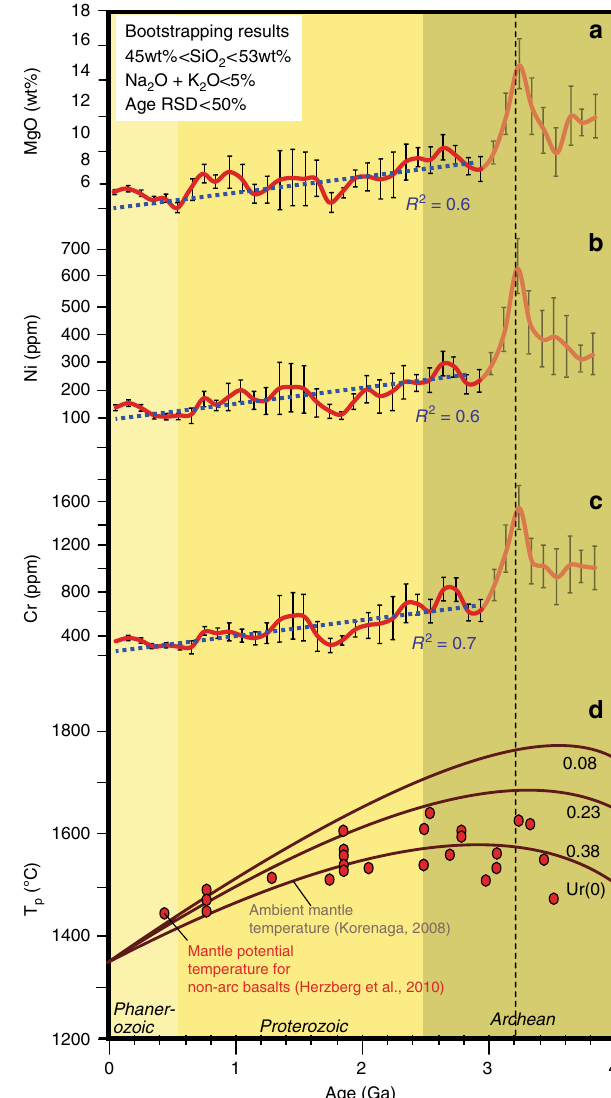
Fig. 3 Time evolution of global mean MgO, Ni, and Cr contents after a bootstrap resampling of the selected basaltic database. The blue dashed lines in a – c are regression lines for data between 0 to 3.0 Ga that reveal fi rst-order secular decreases. Error bars in a – c show 2 s.e.m. (standard error of the mean) uncertainties. d Secular cooling of Earth ’ s mantle based on non-arc basalts 28 and thermal modeling 43 . Urey ratios (Ur) are shown: 0.08 (upper curve), 0.23 (middle curve), and 0.38 (lower